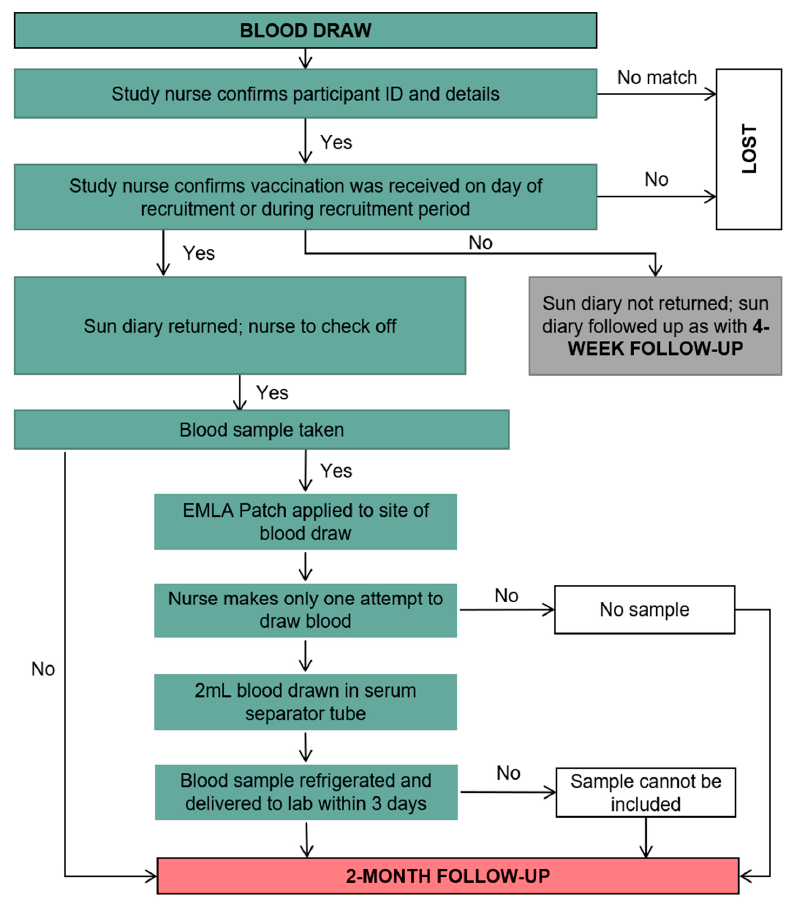
Figure 8. Blood sampling procedure.